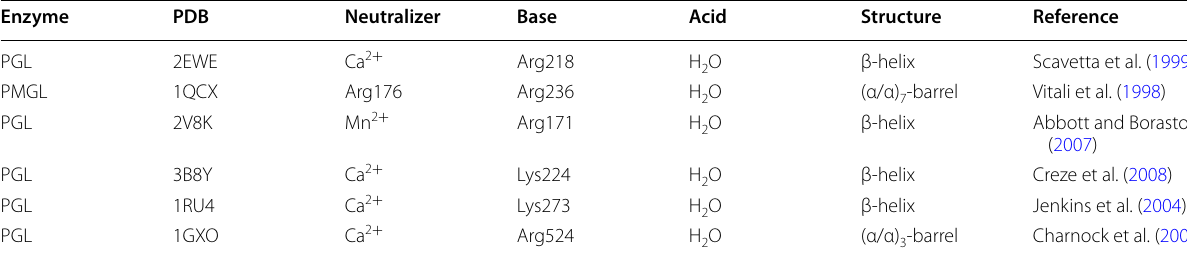
Table 4 The catalytic mechanism of partial PMGL and PGLs Enzyme PDB